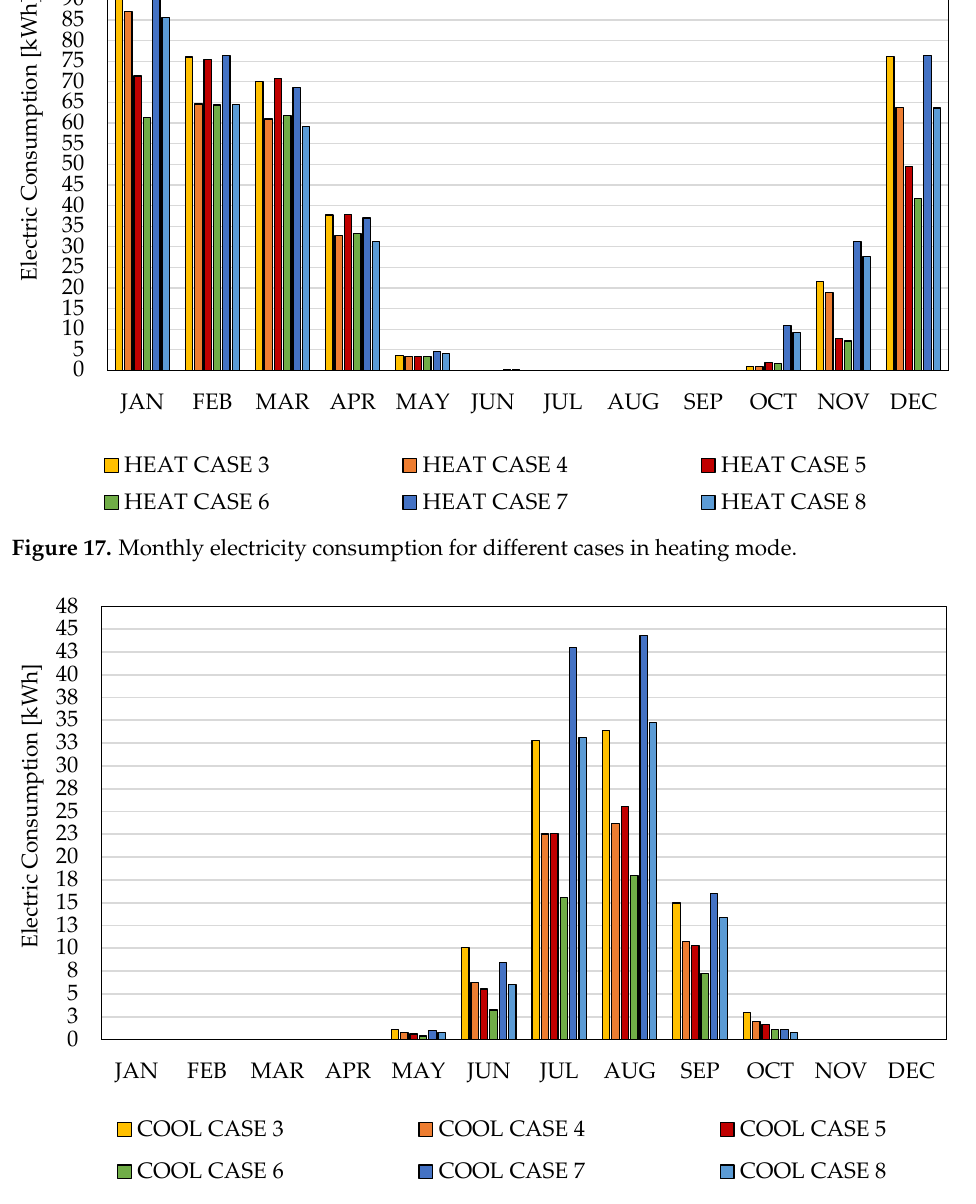
Figure 18. Monthly electricity consumption for the different cases in cooling mode.